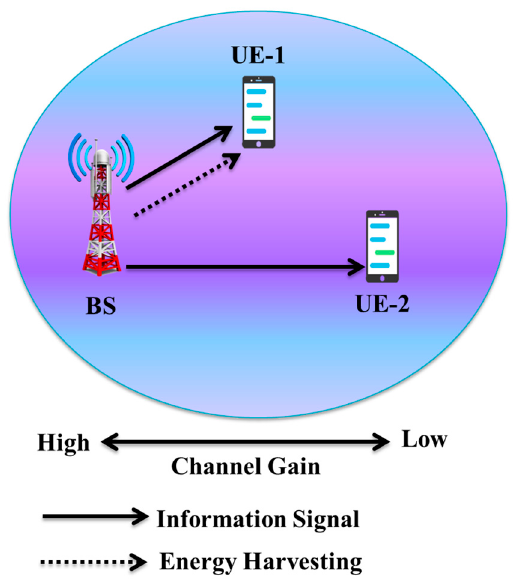
Figure 12. NOMA-enabled SWIPT.